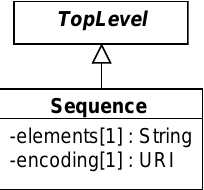
Figure 6: Diagram of the Sequence class and its associated properties.